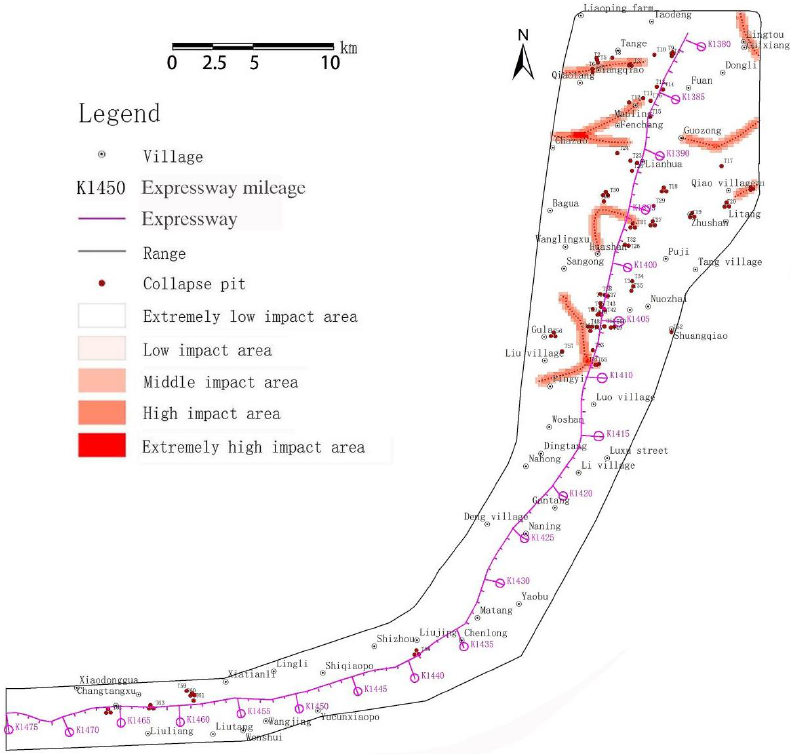
Figure 13. Zoning map of influence degree of underground river on karst collapse.